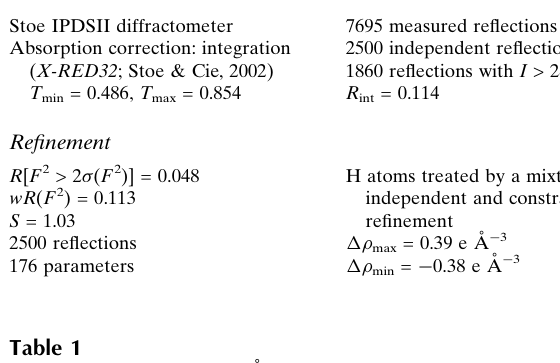
Hydrogen-bond geometry (A˚ , (cid:1)